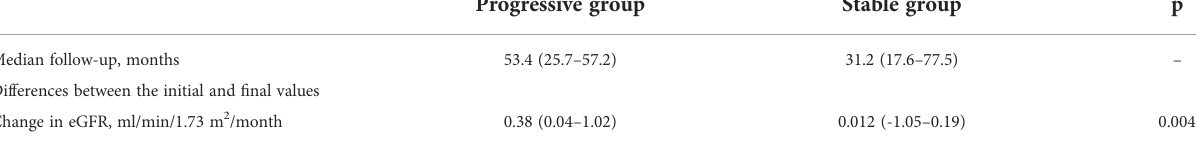
TABLE 3 Change in eGFR over time in IgA nephropathy patients in the progression and stable groups * . Progressive